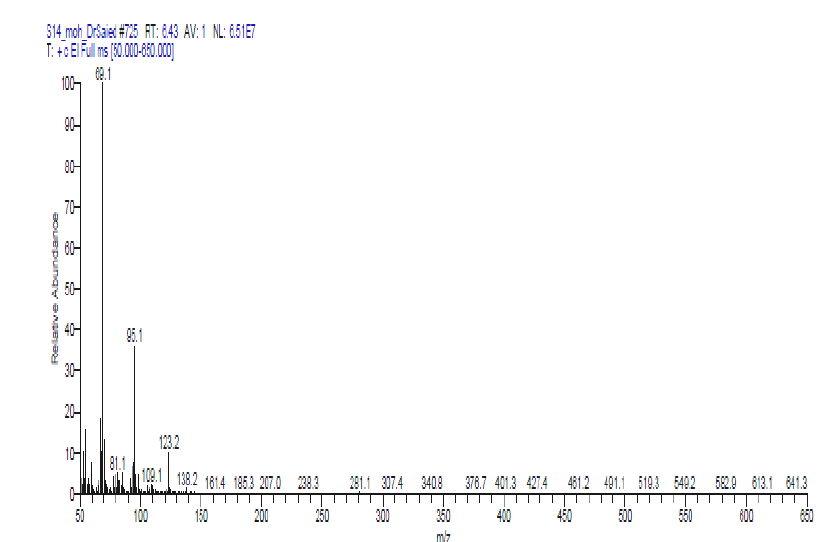
Figure 2. GC-MS chromatographic for identification of compounds in methanolic extract of Solenostemma argel. El-Sonbat et al. [42] recorded twenty-two volatile organic compounds within the methanolic extract of argel, which are xylitol (35.65%), 4- methylcatechol (23.89%), sinapic acid (8.13%), linalool acetate (4.28%), α -Copaene (3.21%), 2- (but-2’-enyl) phenol (2.85%), menthol,1’-(butyn3-one-1-yl)-, (1S,2S,5R)- (2.85%), α -Elemene (2.14%), and junipene (2.14%), were found to be the major constituents, while 7-methoxy-3-(4- methoxyphenyl)- 2,3-dihydro-4H-chromen-4- one (2.14%), β - Guaiene (1.6%); β -Asarone (1.6%), phenol, 4- (3-hydroxy-1-propeenyl)-2-methoxy- (1.5%), isoferulic acid (1.43%), γ -Himachalene (1.25%), L-aspartic acid (1.07%), resorcinol (0.71%), valproic acid (0.71%), 6- monohy- droxyflavone (0.53%), tricosanoic acid (0.53%), apigenin-7-glucoside (0.53%), 3,7,3’,4’- tetra-O-methyl-5-O-(trimethylsilyl) quercetin (0.36%), phenol, 2-methoxy-5-(1-propenyl)- (0.36%), α -Terpineol (0.36%), and 6- hydroxyflavone (0.18%) were the minor constituents. 4. Conclusions The present study concludes that Solenostemma argel contains considerable quantities of phenolic compounds, flavonoids, and volatile compounds. S. argel is a very promising source of novel non-toxic, anti-inflammatory, and antioxidant compounds. It can be also used in the food industry as an antimicrobial agent. These results also provide a scientific basis for its use in cancer treatment. However, further studies are necessary to find active components in Solenostemma argel extract and to confirm its mechanism of action. Author Contributions: R.M.E. established the study design and provided the research strategy, wrote the draft, and reviewed; Y.A.K. established the study design and provided the research strat- egy; M.S.M.S., G.O.O.H. assessed the experiments and provided the data analysis; M.A.A., A.R.A.H. resources; A.A. tables and figures, statistical analysis, writing and editing. All authors have read and agreed to the published version of the manuscript. Funding: This research was funded by Deanship of Scientific Research, Qassim University, King- dom of Saudi Arabia. Institutional Review Board Statement: Not applicable. Informed Consent Statement: Not applicable.